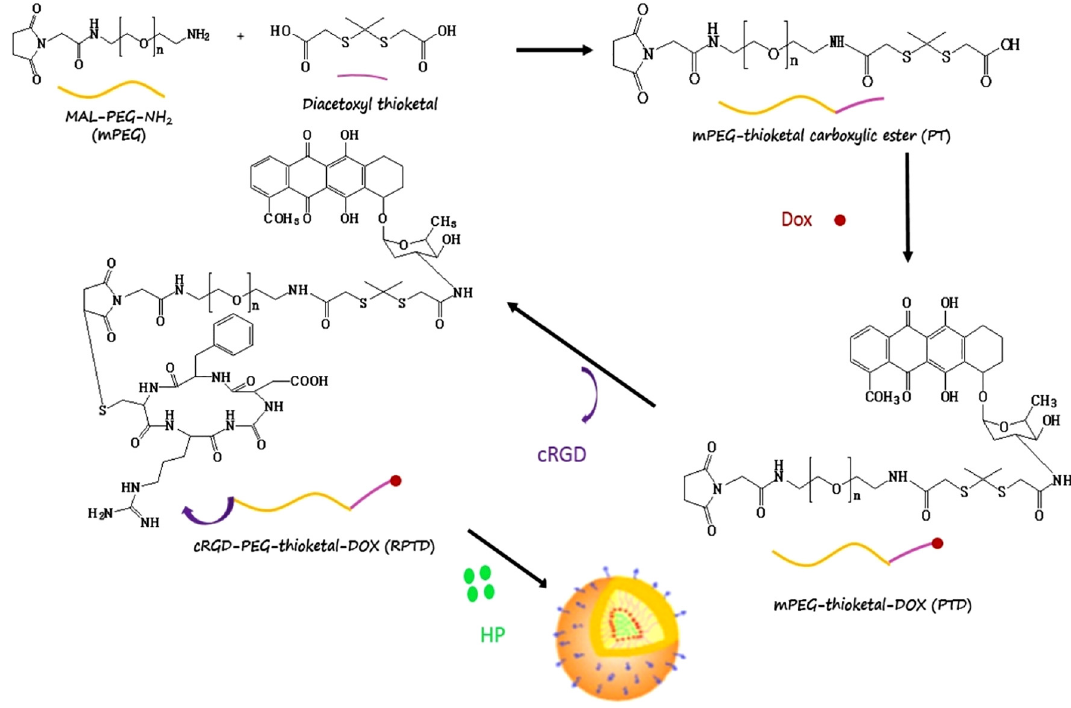
Figure 15: Synthesis of RPTD/HP NPs. Adapted from Shi et al.